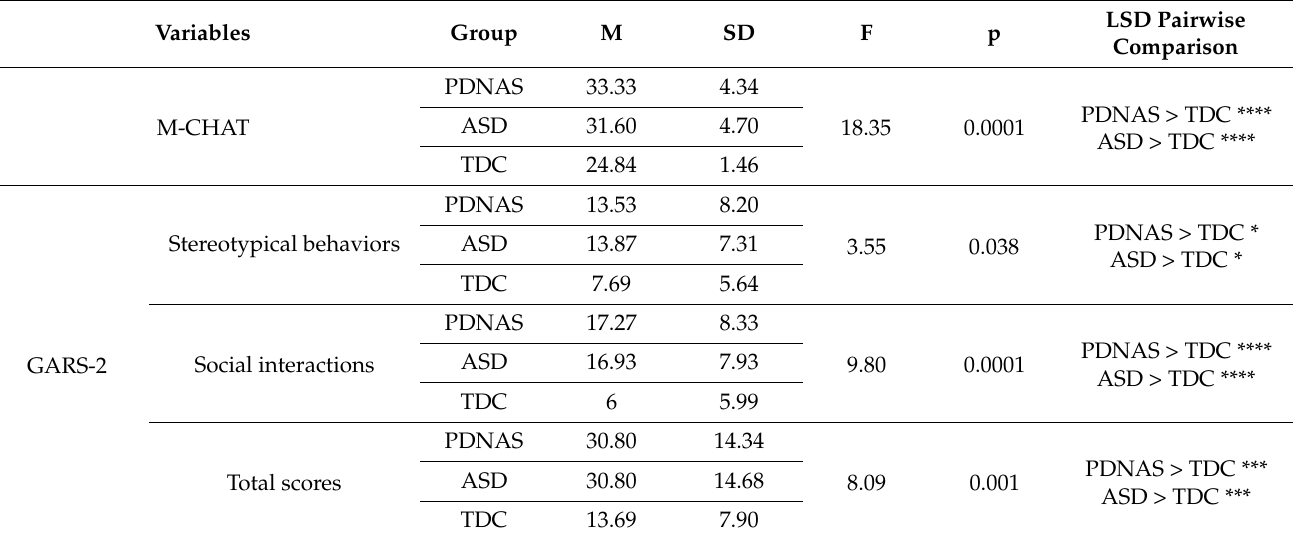
Table 3. Comparison of the severity of autism symptoms in two groups.